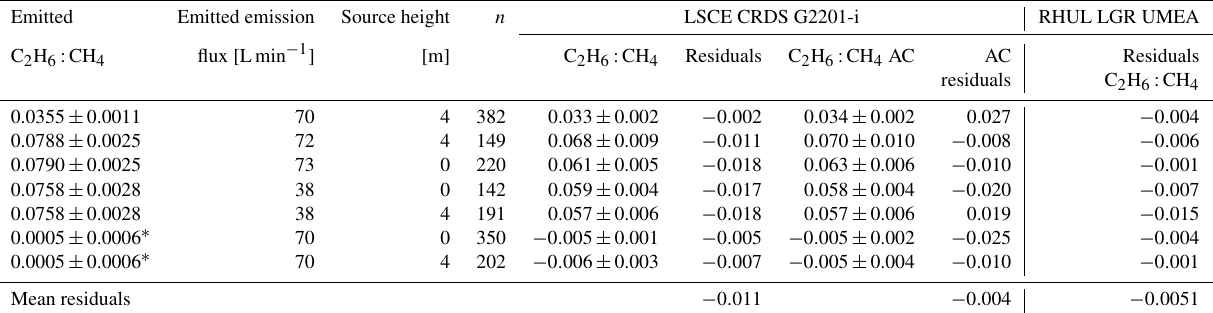
Figure 6. Controlled release experiment. C 2 H 6 : CH 4 observed using G2201-i as a part of a mobile setup. (a) Measured standing inside the plumes. (b) Measured using AirCore. Red points: known released C 2 H 6 : CH 4 . Error bars represent 1 standard deviation. The uncertainties in released values are invisible on the graph. Table 5. Controlled release experiment. C 2 H 6 : CH 4 with residuals for non-averaged data observed using G2201-i as a part of a mobile setup while standing inside the plume or from AirCore (AC) measurements. Background subtracted for both C 2 H 6 and CH 4 before determination of C 2 H 6 : CH 4